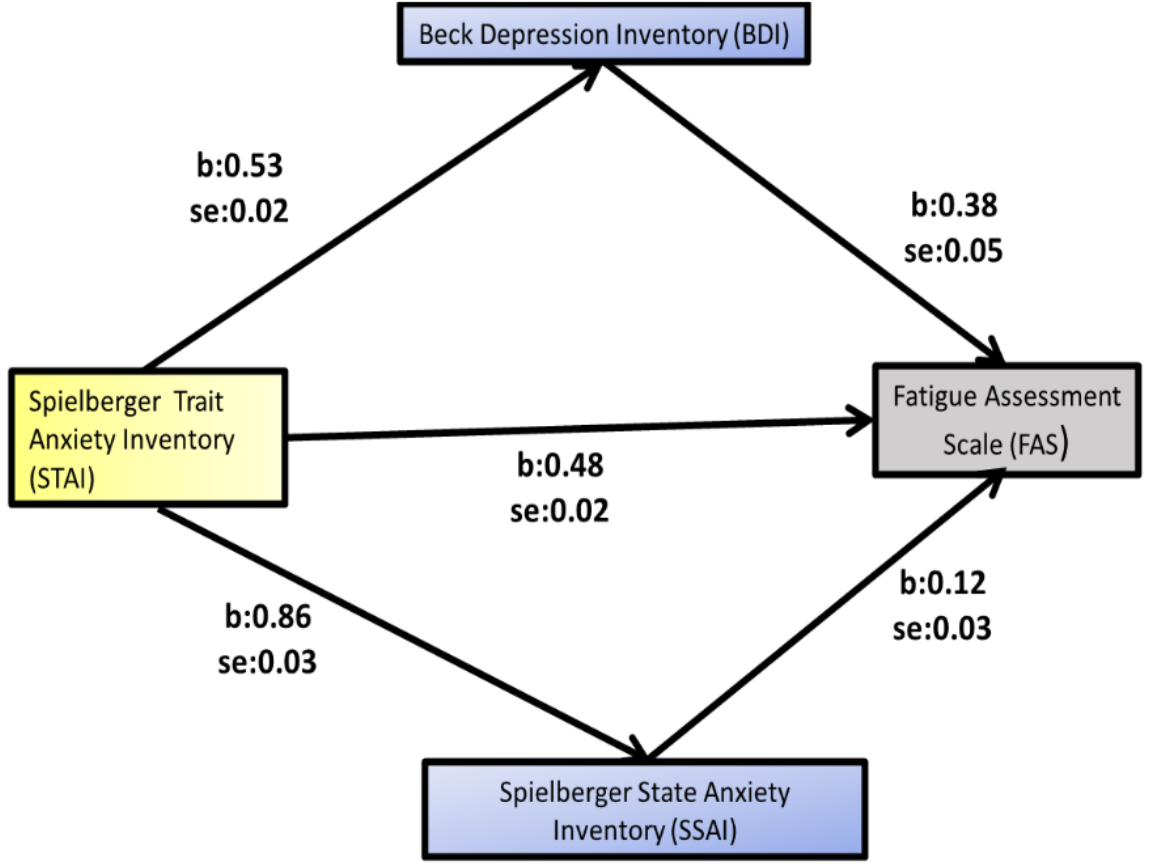
Figure 1. Mediation analysis of Beck Depression Inventory and Spielberger State Anxiety Inventory on Spielberger Trait Anxiety Inventory–Fatigue Assessment Scale relationship (Model 4 with multiple mediators).